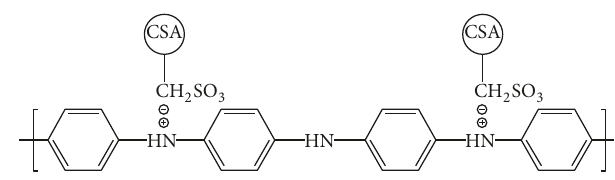
Figure 5: Interaction of the camphor sulfonic acid with polyaniline.